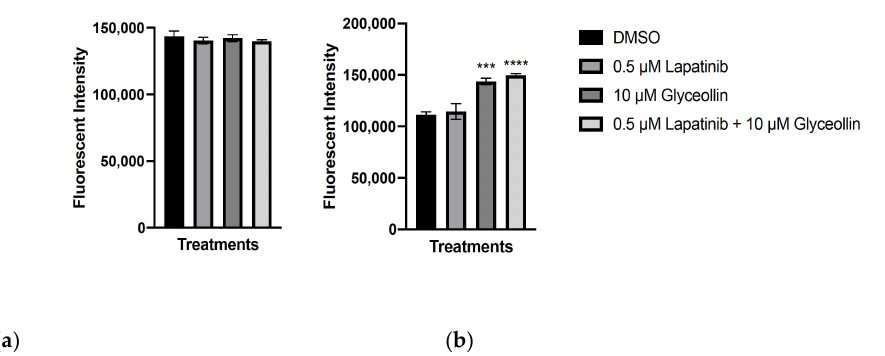
Figure 6. Glyceollin induces apoptosis regardless of aromatase inhibitor sensitivity. ( a ) The T47Darom and ( b ) T47DaromLR cells were used to measure caspase 3/7 activity. T47DaromLR cells were withdrawn from letrozole for 7 days prior to treatment. Cells were treated with control (DMSO), 0.5 µ M lapatinib, 10 µ M glyceollin, and 0.5 µ M lapatinib in combination with 10 µ M glyceollin, and apoptosis studies were performed. Caspase activity was measured by reading the fluorescence of cells read at 530/502 nM wavelengths. Student’s t -tests were performed, and treatments were compared to the DMSO control. Results are expressed as the mean unit ± SD (**** p < 0.0001, *** p < 0.001) of three independent experiments in